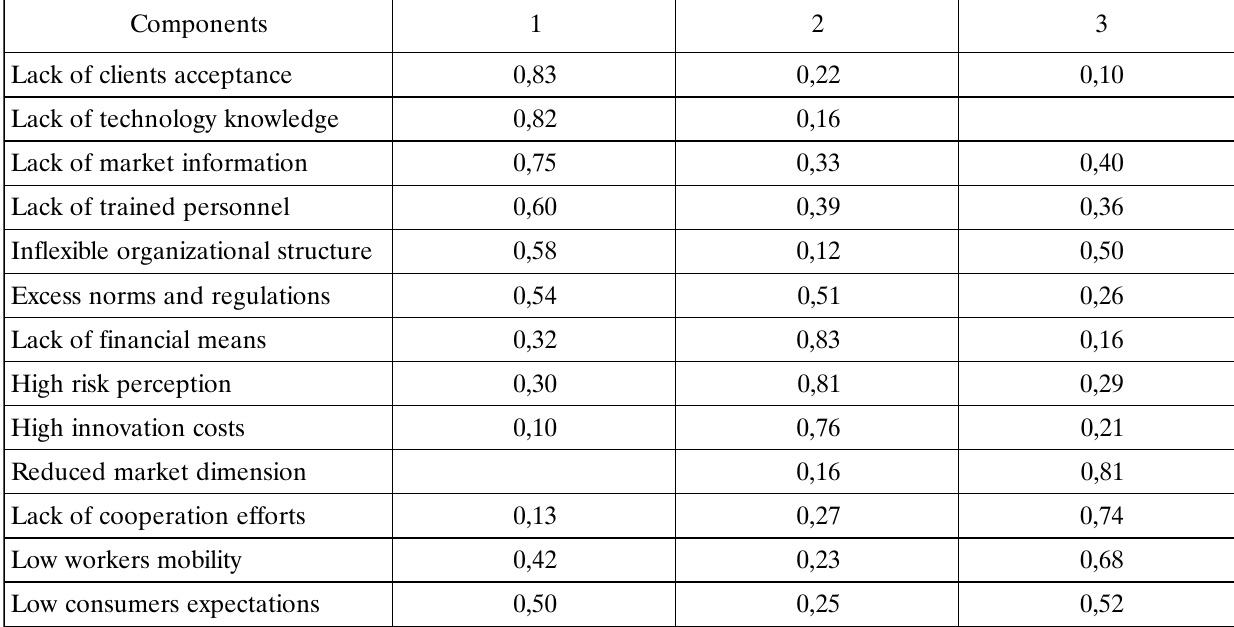
Table 7b. Rotated Solution – Innovation